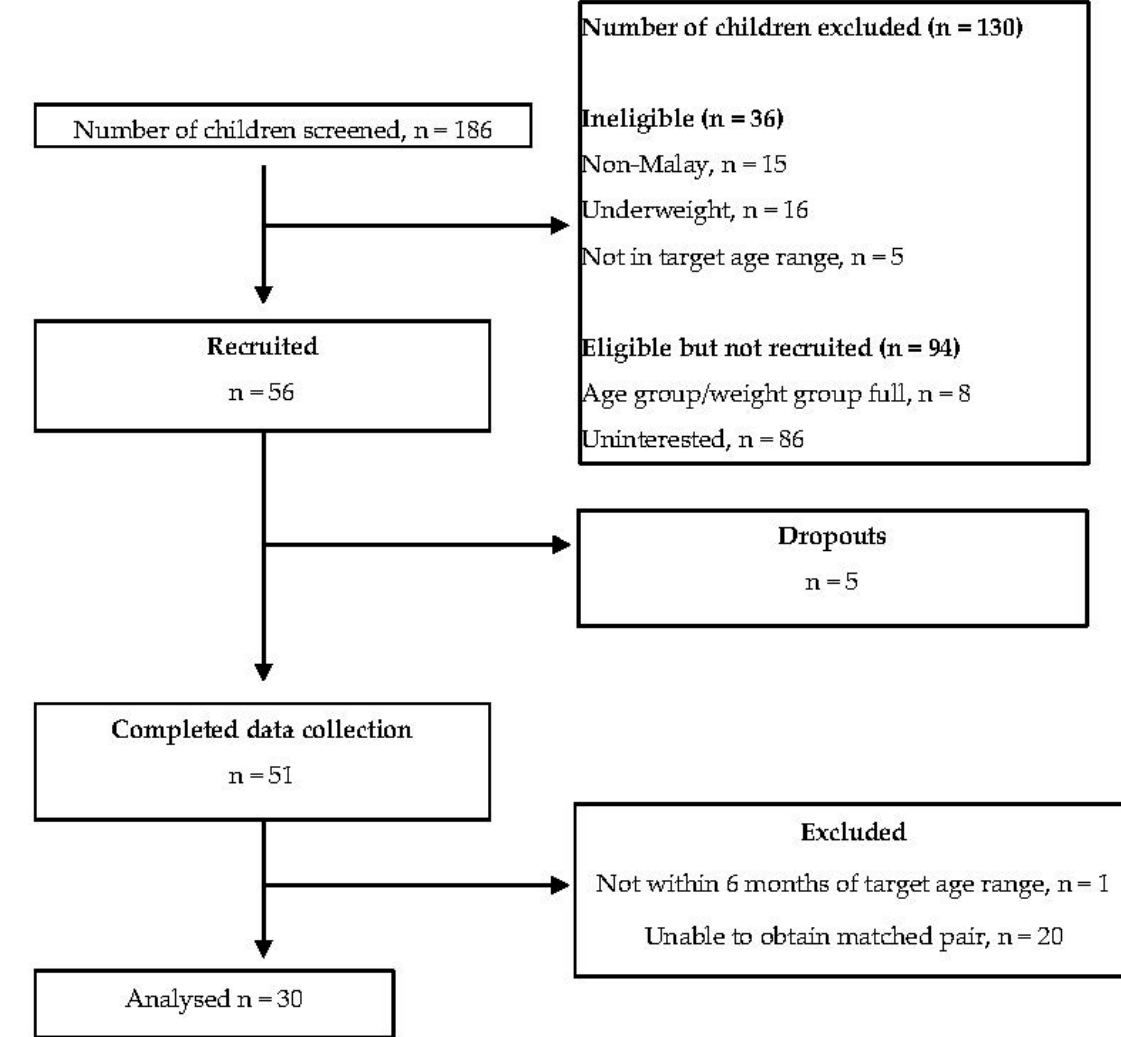
Figure 1. Flow chart indicating screening, recruitment, data collection and data analysis.